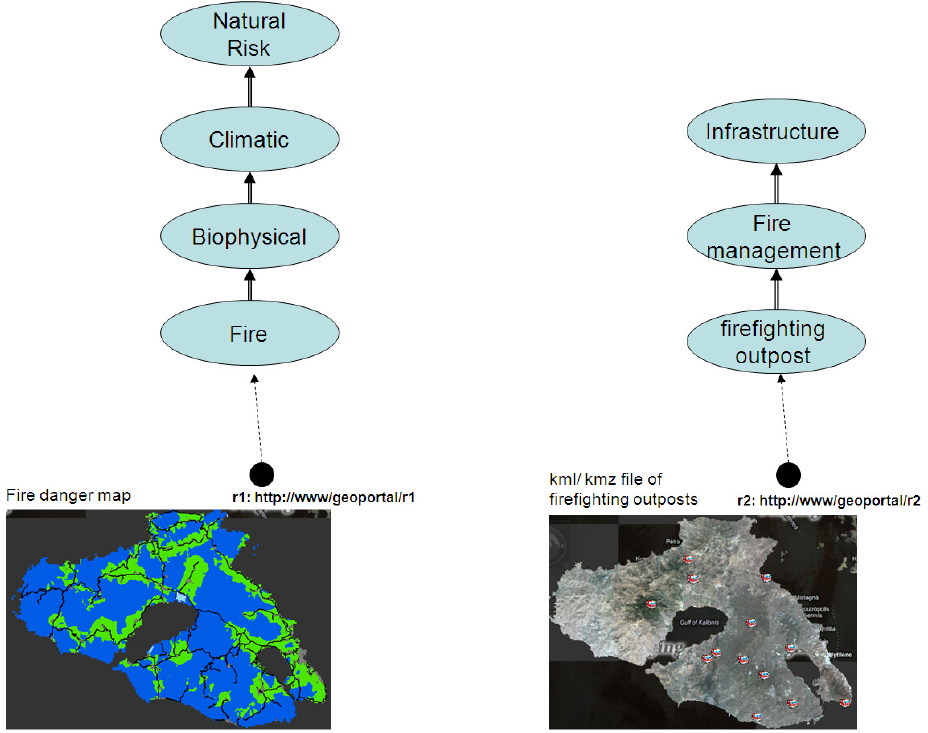
Fig. 11. Classification of resources in the OntoFire ontology.